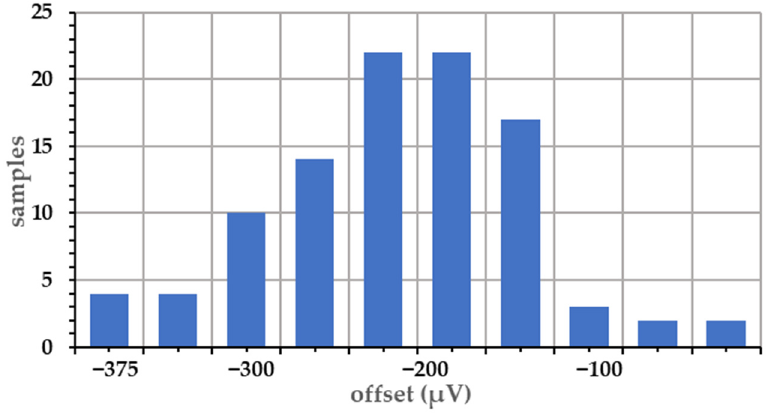
Figure 8. Amplifier offset distribution from 100 Monte-Carlo simulation runs.